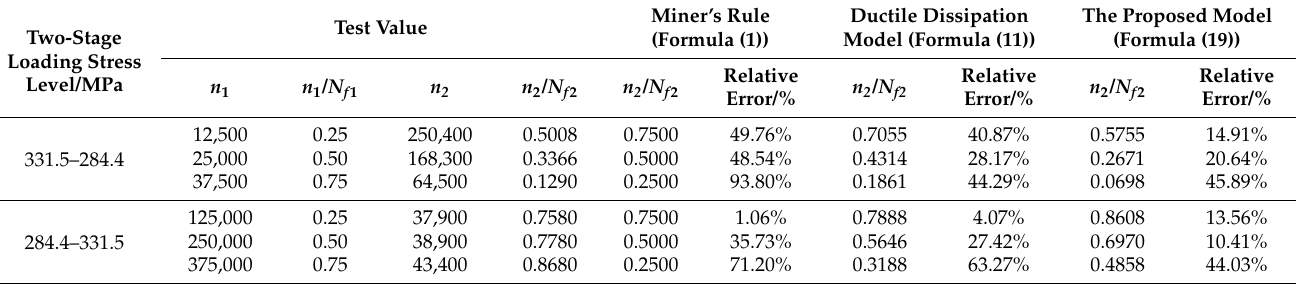
Table 5. The 45# steel two-stage loading test data and remaining life prediction results of each model. Two-Stage Loading Stress